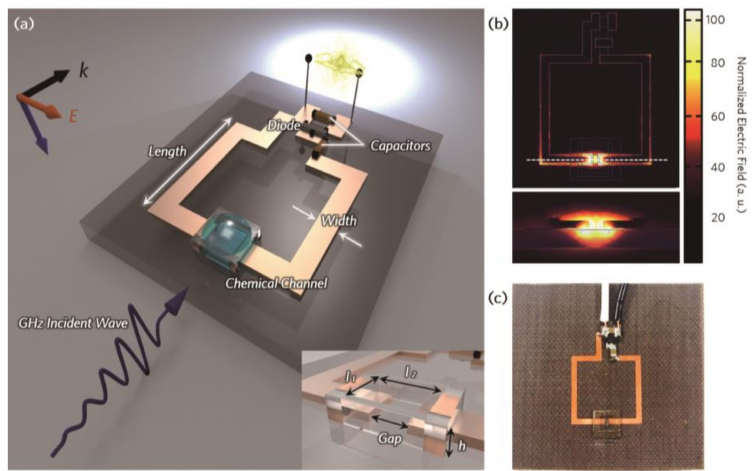
Figure 1. Schematics of the proposed system and design. ( a ) Schematic of the proposed energy-harvesting metamaterial sensor system. ( b ) Top and cross-sectional views of the simulated electric field distribution of the proposed metamaterial device at the resonance frequency. ( c ) Photograph of the fabricated metamaterial sensor